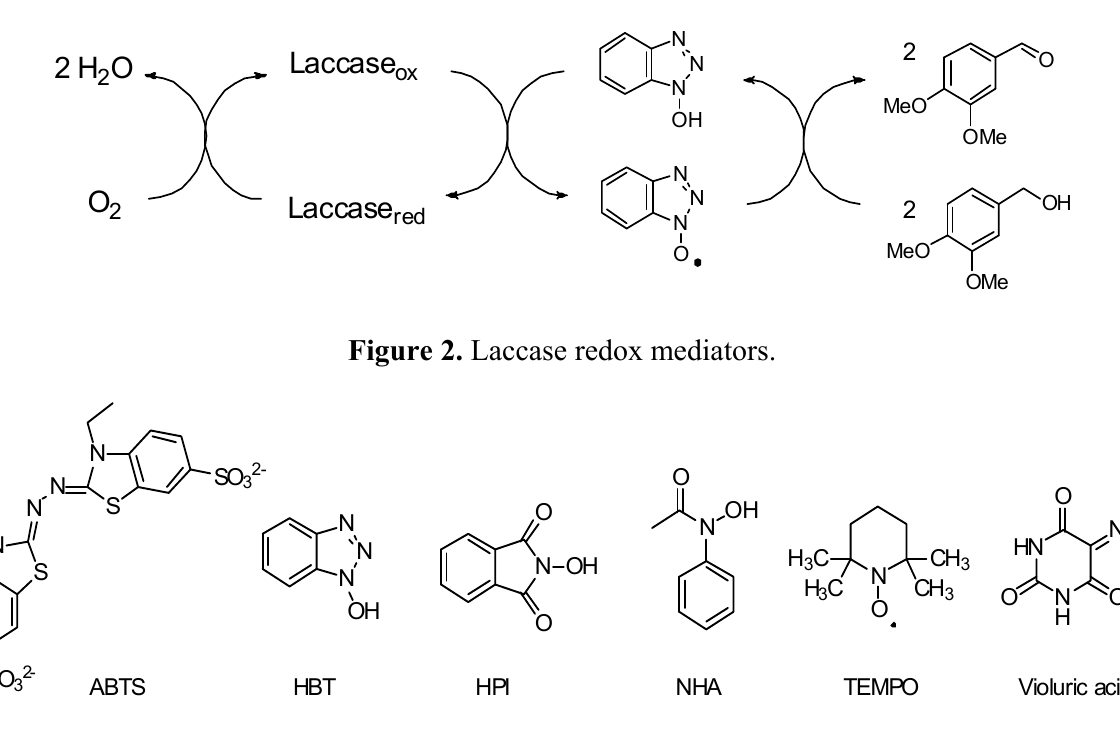
Figure 1. HBT-mediated oxidation of veratryl alcohol to veratraldehyde by laccase.